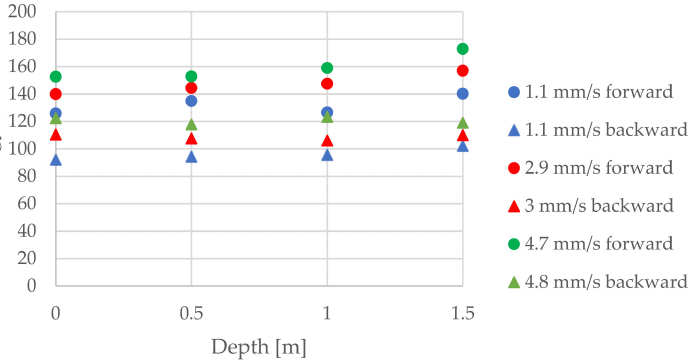
Figure 21. Energy measurements at different depths (0 m, 0.5 m, 1 m and 1.5 m) and speeds (DC = 20%, DC = 50%, DC = 80%).